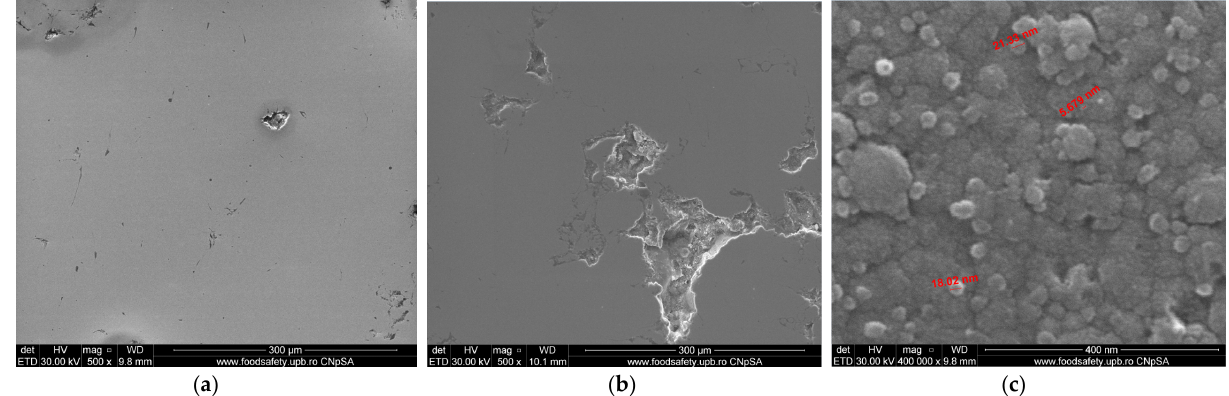
Figure 11. The FE-SEM analysis of samples coated with a thin film of 75%Ta 2 O 5 and 25%ZnO: ( a ) Sample S5 of the cast 304L stainless steel (500×). ( b ) Sample S6 of Co–Cr alloy manufactured via DMLS (500×). ( c ) Thin film grains of 75%Ta 2 O 5 and 25%ZnO (400,000×). The particle distribution of the chemical elements for sample S5 was OK 19.33%, CrK 16.18%, FeK 55.58%, NiK 5.77%, TaL 2.18%, and ZnK